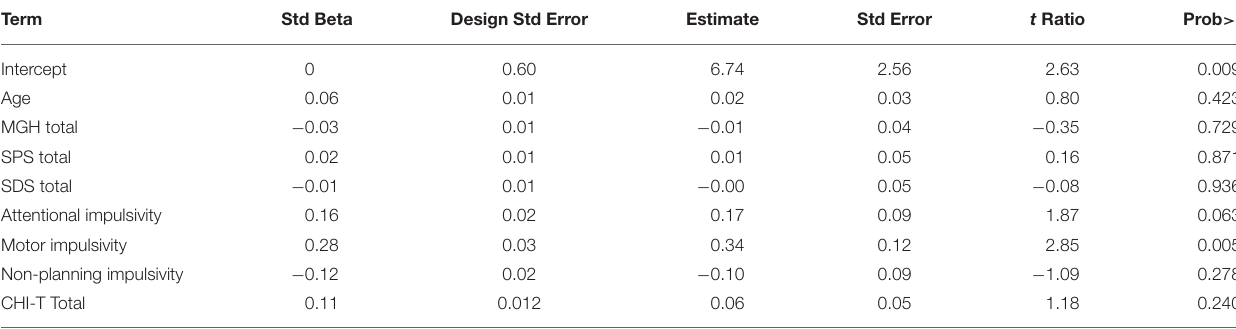
TABLE 3 | Regression model results, linking explanatory variables to fat-sugar intake.